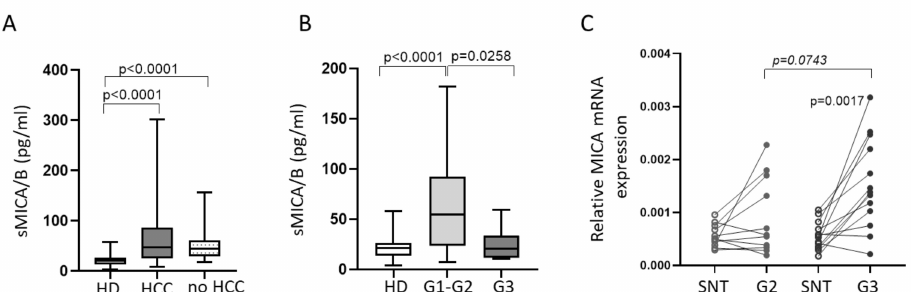
Figure 2. sMICA / B concentrations are increased in patients with HCC. ( A ) Soluble MICA / B (sMICA / B) was tested in sera of 45 HD, 73 HCC, and 19 no HCC subjects. ( B ) sMICA / B concentrations in HCC patients stratified according to the grades of tumor di ff erentiation G1, G2, and G3 (well, moderately, and poorly di ff erentiated, respectively). G1: n = 24; G2: n = 18; G3: n = 10. ( C ) mRNA levels in G2 ( n = 11) and G3 ( n = 13) tumors and in their matched surrounding non-tumor (SNT) specimens. Middle bars represent median values, box plots are 25% and 75% percentiles, whiskers are minimum and maximum values. The Mann–Whitney U test or Wilcoxon matched-pairs signed rank test were used to compare